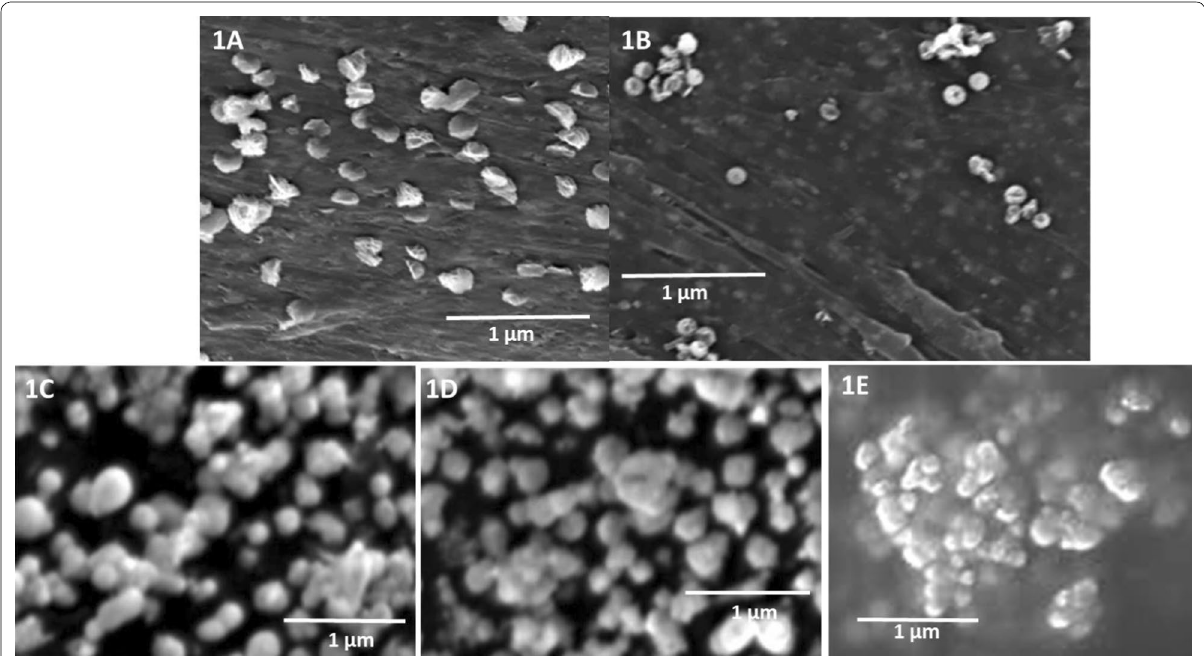
Fig. 1 SEM of ( a ) CuO NPs; b FOL‑PLGA‑CuO NPs; c CD‑1; d CD‑2; e CD‑3. Note the irregularities in size and shapes of CuO NPs in ( a ). Upon incorporation of drugs the shapes gradually become spherical with agglomeration of